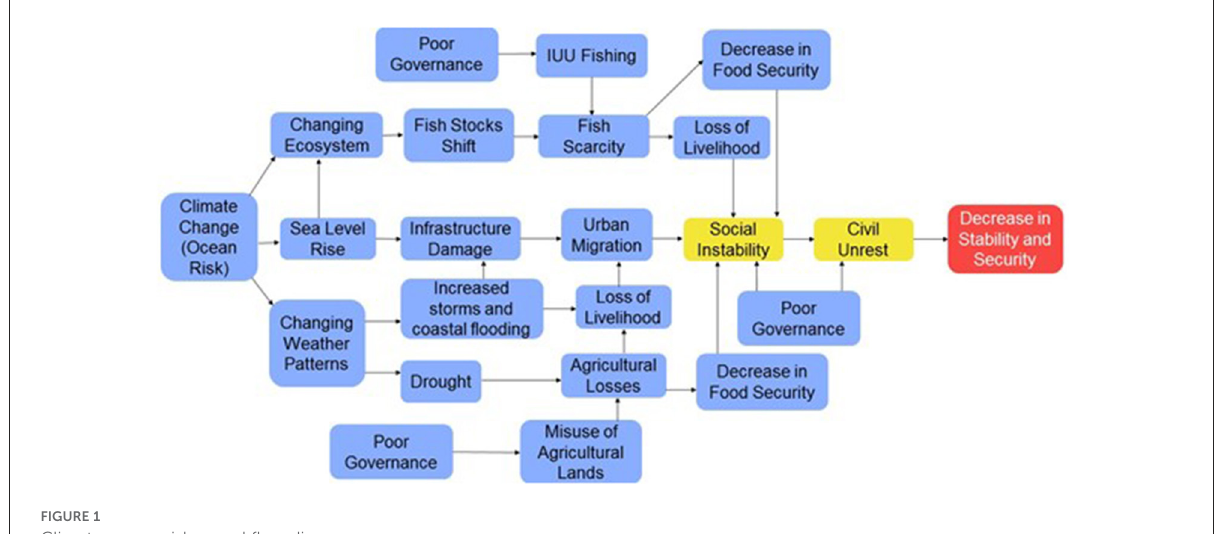
FIGURE1 Climate-ocean risk causal flow